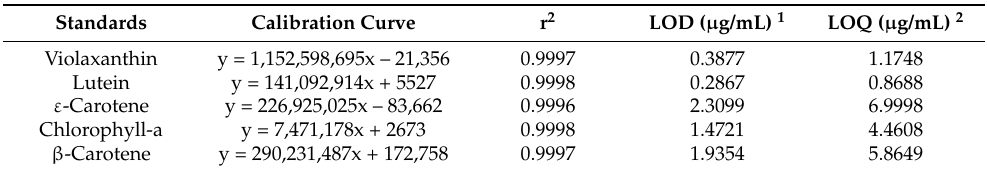
Table 2. Calibration curves of authentic standards used for quantification of different Carotenoids and Chlorophyll- a